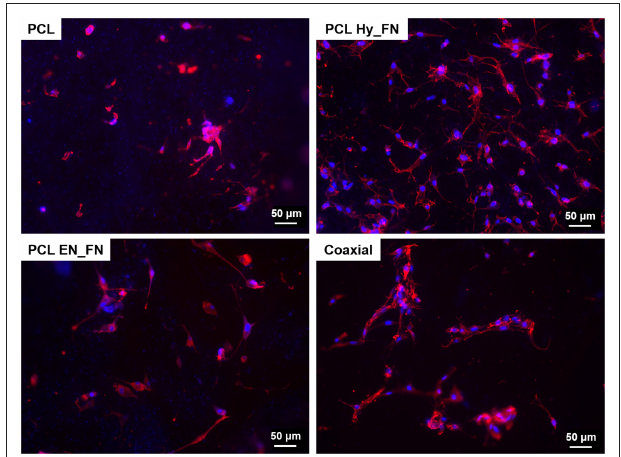
FIGURE 11 | Fluorescence images of actin filaments (red) and cell nuclei (blue) for the samples PCL, PCL Hy_FN, PCL EN_FN, and coaxial 7 days after the seeding.